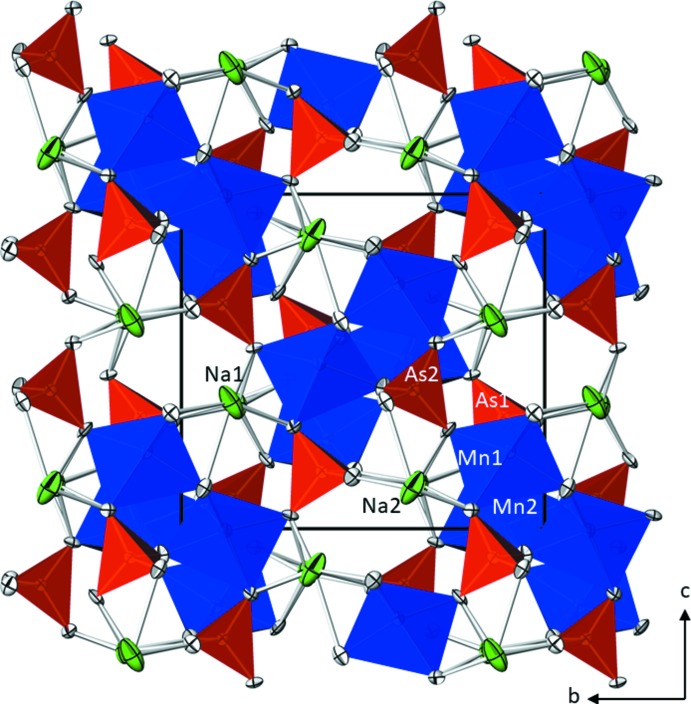
The crystal structure of β-NaMnAsO4 in a projection along [00]. [MnO5] polyhedra are shown in blue, [AsO4] tetra­hedra in red, NaI cations in green and O atoms in shaded grey. Displacement ellipsoids are drawn at the 90% probability level.